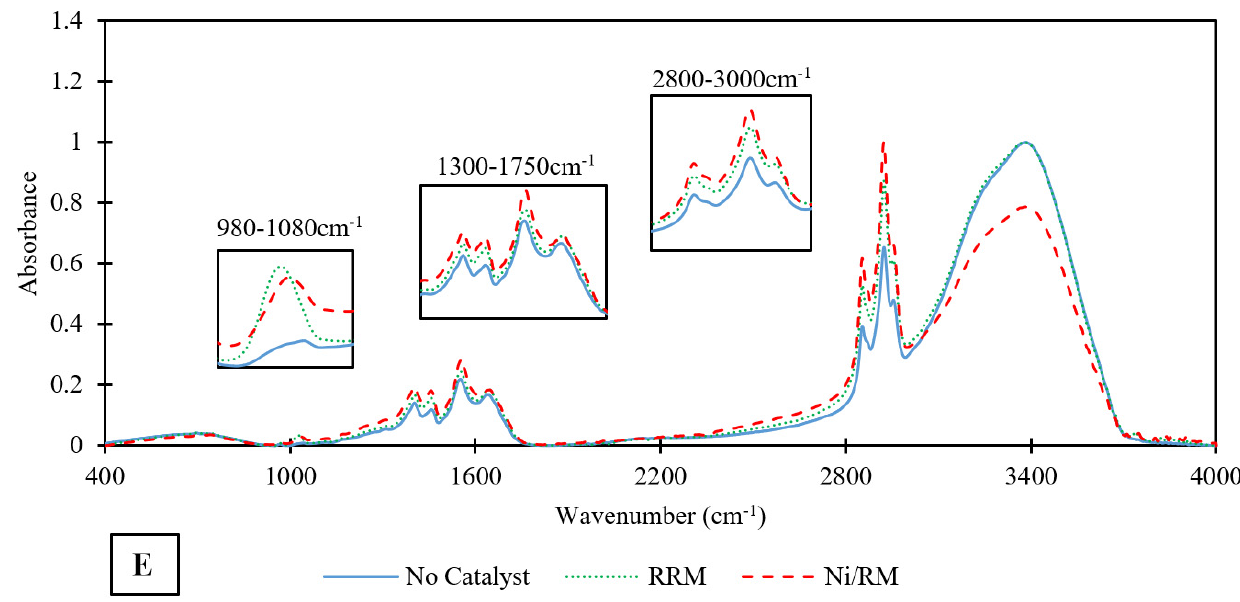
Figure 4. FTIR spectra of Tetraselmis biocrudes, ( A )—non-catalytic reactions, ( B )—reactions under nitrogen environment, ( C )—reactions under ethylene environment, ( D )—reactions under reducing environment and ( E )—reactions under oxidizing environment.